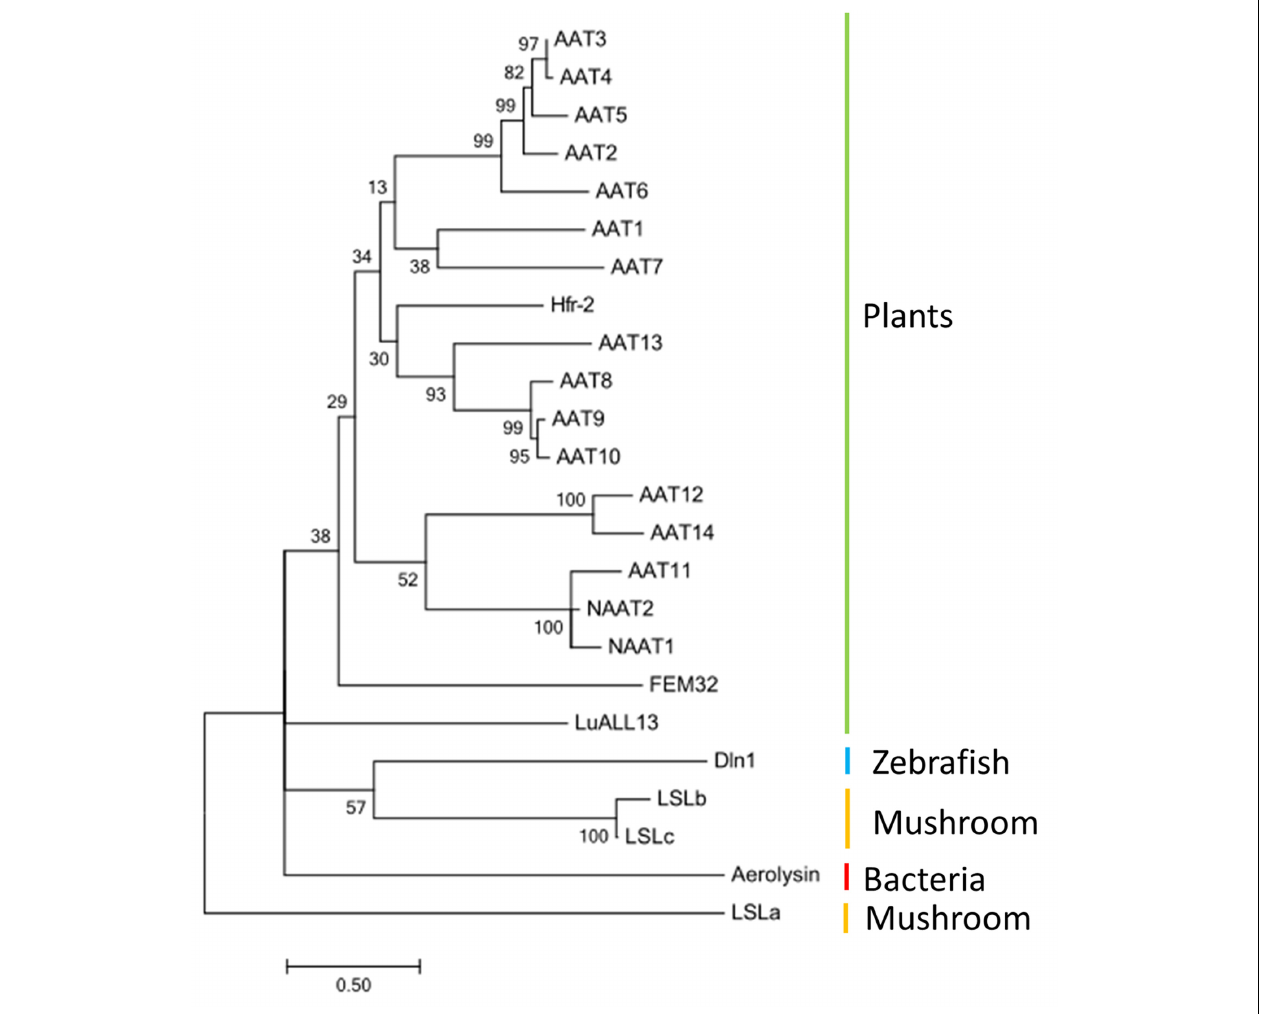
FIGURE 9 | Phylogeny of aerolysin-like domain from different species: AAT1–AAT14, NAAT1, and NAAT2 ( Cucumis sativus ), Hfr-2 ( Triticum aestivum ), LuALL13 ( Linum usitatissimum ), FEM32 ( Rumex acetosa ), Aerolysin ( Aeromonas hydrophila ); Dln1 ( Danio rerio ), LSLa, LSLb, LSLc ( Laetiporus sulphureus ). The tree was built with MEGA6 and the bootstrap value next to the branches was estimated using the bootstrap test (500